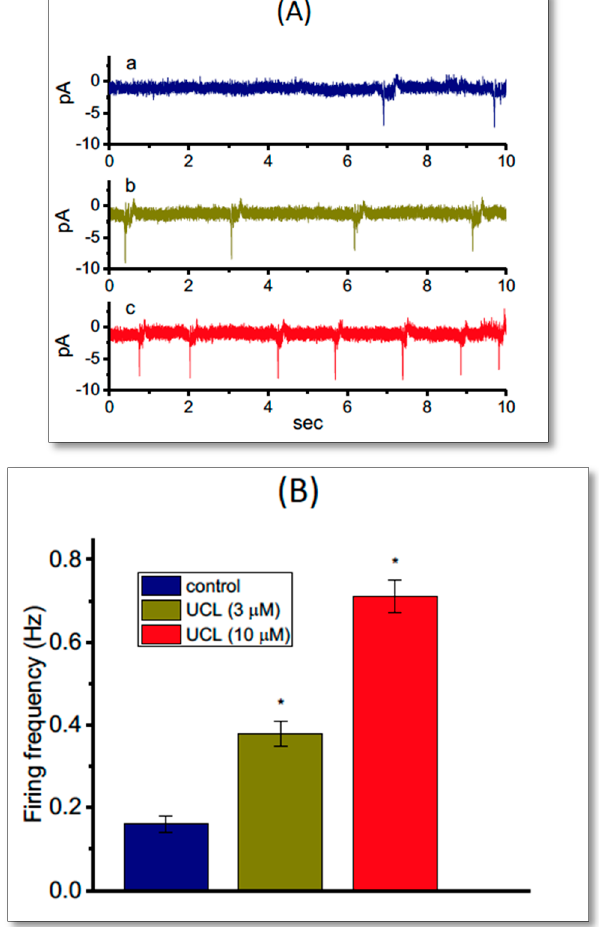
Figure 8. Stimulatory e ff ect of UCL-2077 on action currents (ACs) identified from voltage-clamped